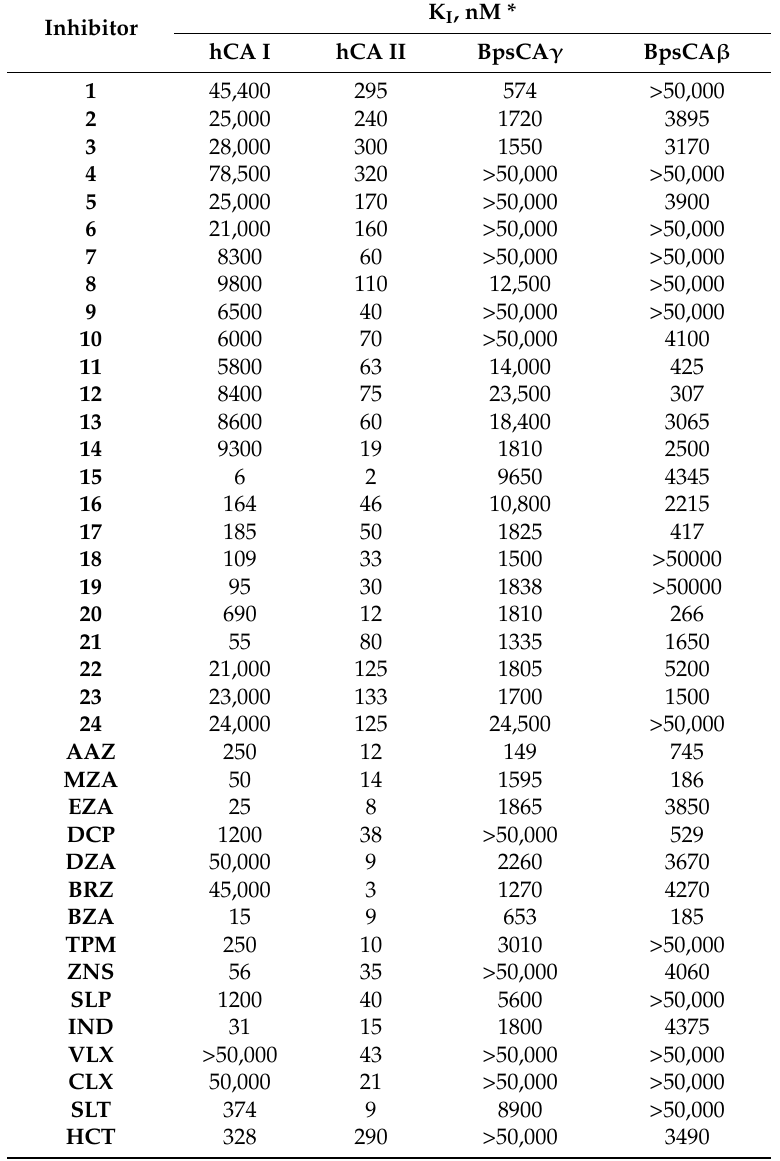
Table 3. Sulfonamides/sulfamates inhibition constants (K I , nM) for the human α -CAs (isoforms hCA I and II) and the β -/ γ -CAs identified in the genome of B. pseudomallei , assayed by a CO 2 hydrase stopped flow method